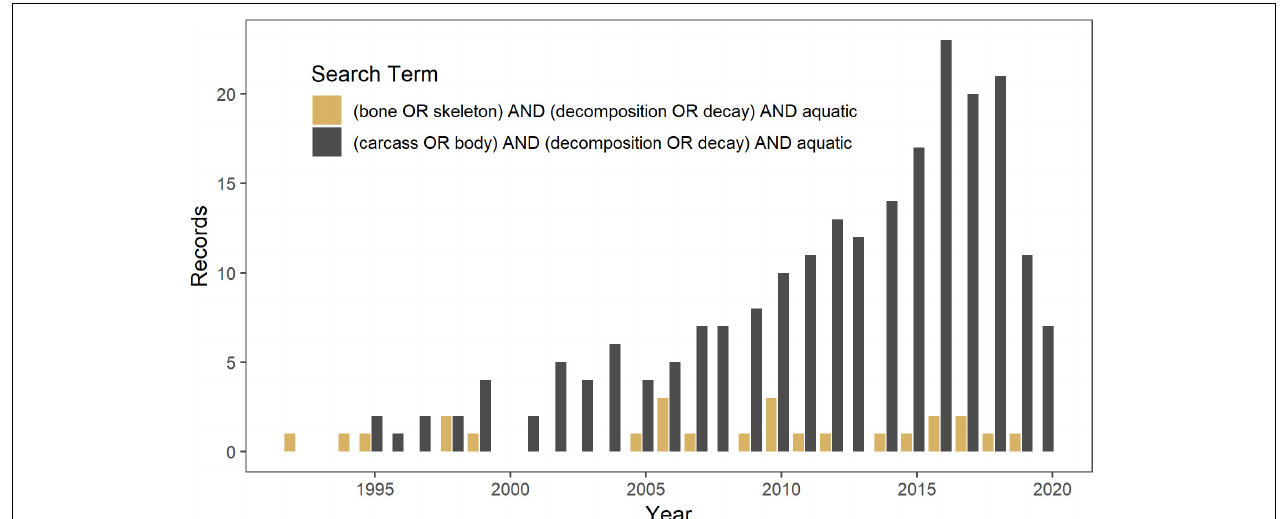
FIGURE 1 | Web of Science search conducted on 14 March 2019 for literature since 1990 on decomposition in aquatic ecosystems of carcasses (in gray) versus bones (in